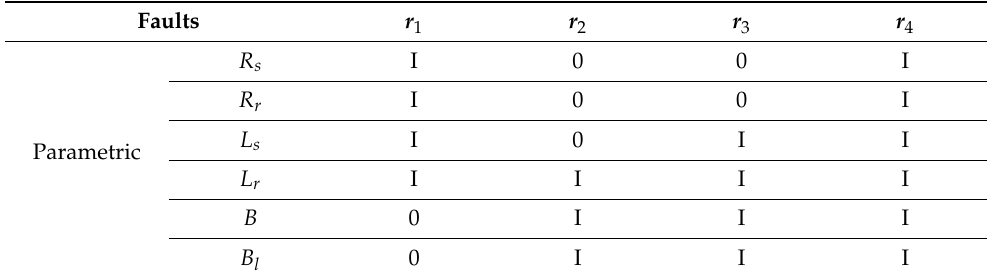
Table 1. Fault detection matrix using the D-Q